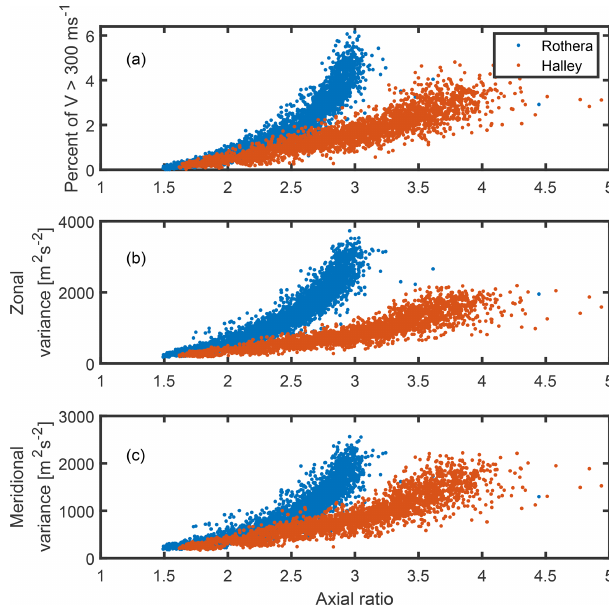
Figure 9. The relationship between axial ratio and (a) outliers and (b) hourly variance of the zonal wind and (c) hourly variance of the meridional wind. Each point represents a different hour, month and altitude, to isolate the effect of differing error levels. Only altitudes over 80km are shown. Meridional and zonal winds show substan- tially the same relationship, with slightly smaller variance in the meridional direction (reflective of the lower wind